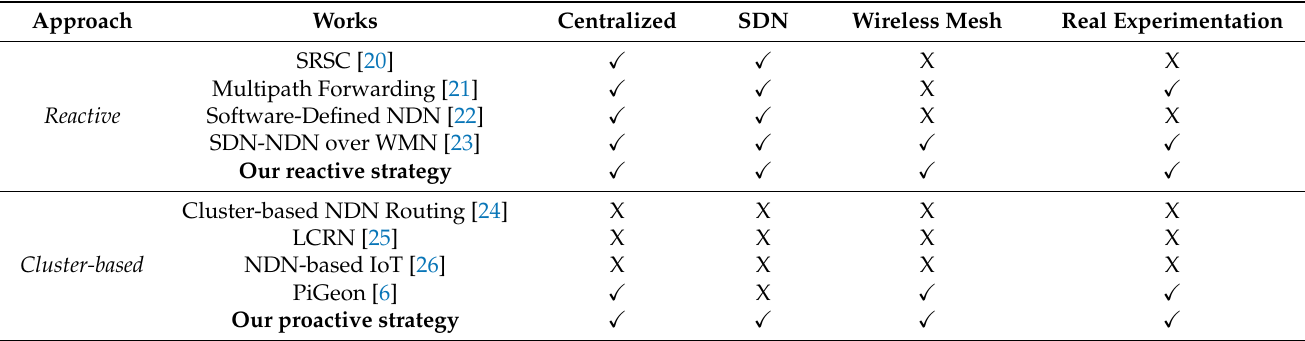
Table 1. Related Work